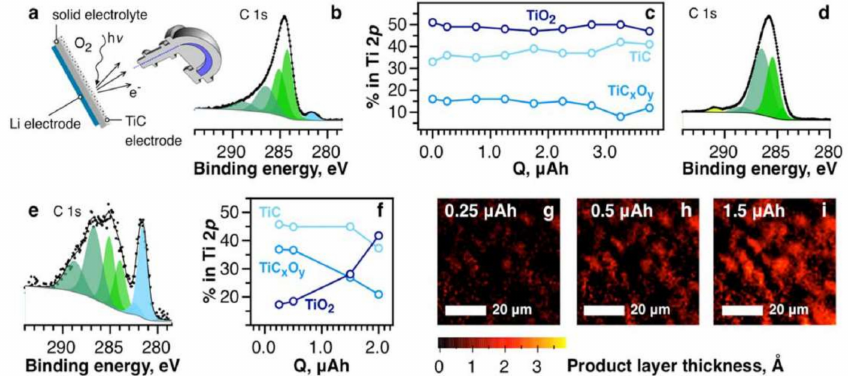
Figure 3. ( a ) Graphical representation of operando spectroscopy under an Ar atmosphere using an Li-metal, NASICON, and nanopowder TiC as anode, conducting the electrolyte and cathode, respectively. ( b ) C1s spectra of the TiC cathode before discharge (fresh cell). ( c ) Percentage of components in the Ti2p spectra during the discharge process (galvanostatic mode). ( d ) C1s spectra of the TiC cathode after discharge. ( e ) C1s spectra of the TiC cathode after Ar + sputtering. ( f ) Percentage of components in the Ti2p spectra in a scrubbed electrode. ( g – i ) The discharge product layer’s e ff ective thickness on an Ar + -sputtered TiC cathode at various discharge depths [70]. Copyright 2016 The American Chemical